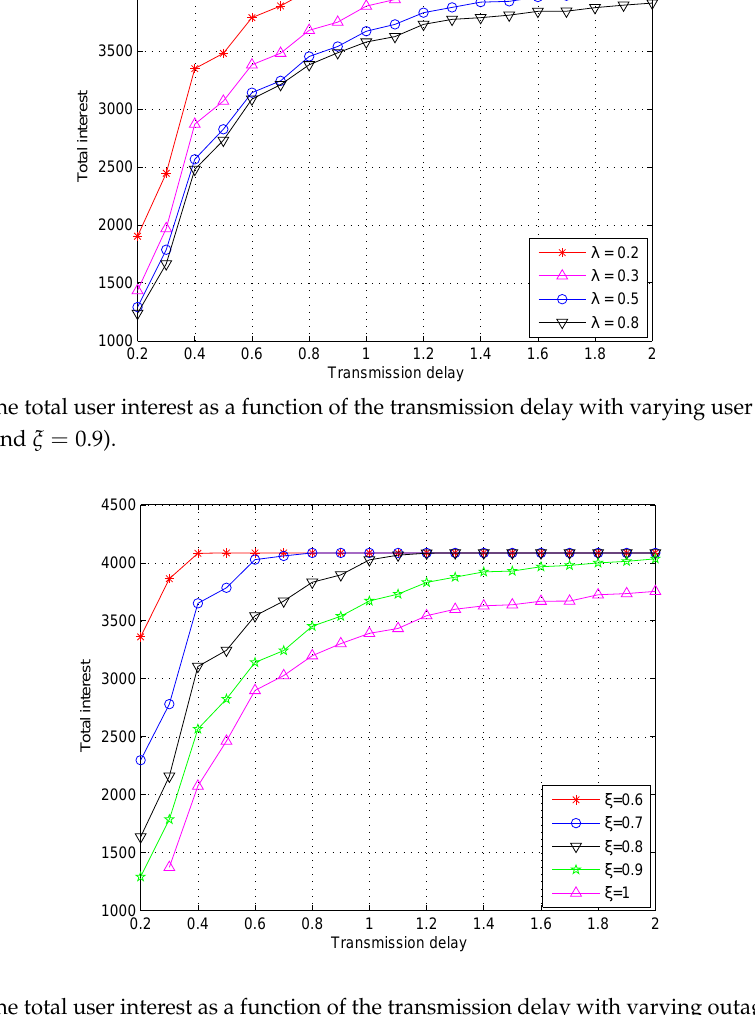
Figure 8. The total user interest as a function of the transmission delay with varying outage probability ξ ( P T = 2 W and λ =